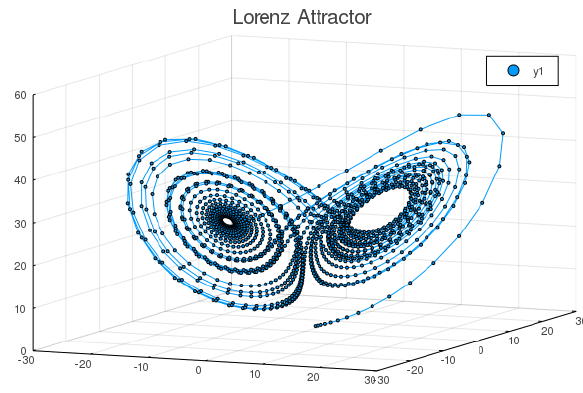
Figure 3. Lorenz